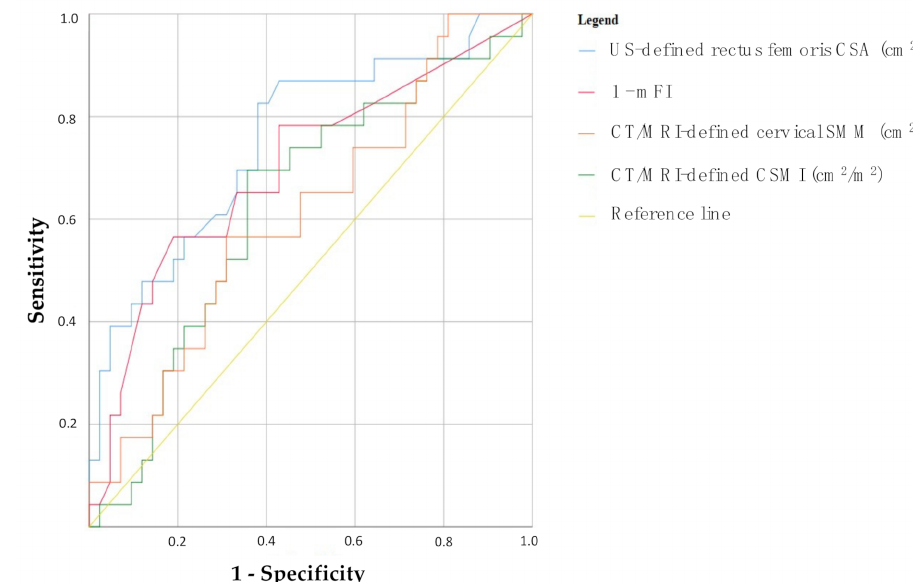
Figure 5. Receiver-operating characteristic curves of ultrasonographically-defined rectus femoris cross sectional area, CT/MRI-defined cervical skeletal muscle mass, CT/MRI-defined cervical skeletal muscle index and modified frailty index in terms of best prediction of 30-day major postoperative complications; US: ultrasound; CT: computed tomography; MRI: magnetic resonance imaging; SMM: skeletal muscle mass; CSMI: cervical skeletal muscle